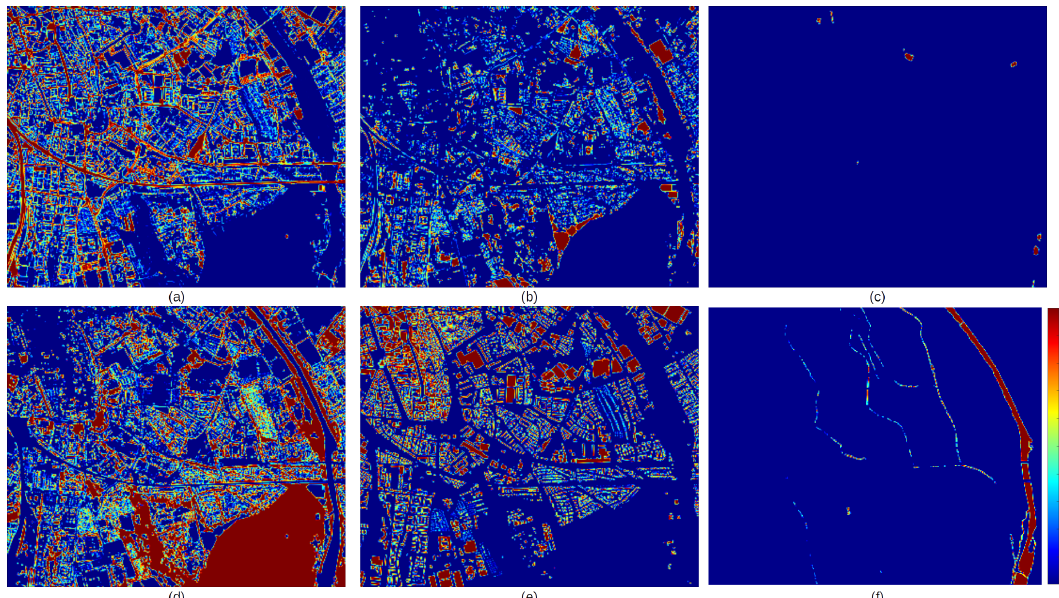
Figure 12. Ground truth of abundance maps of the sub2 region of the EeteS_EnMAP_10 data. (a) Pavement. (b) Low vegetation. (c) Soil. (d) Tree. (e) Roof. (f) Water.